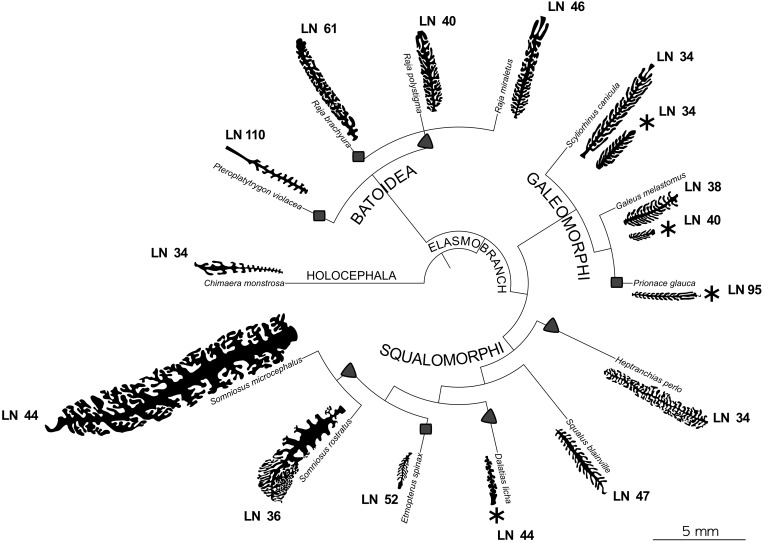
Phylogenetic tree of the species of interest. For each species the silhouette of a illustrative primary lamella with secondary folds is plotted. All the silhouettes are proportionally drawn, having the same scale. For the species where two specimens were analyzed, both the silhouettes are present. For each species the lamellar number (LN) is reported. Specimens with an asterisk are those which are possibly newborn or very young. Chimaera monstrosa is the outgroup and is characterized by less than 50 primary lamellae and by short, unbranched secondary folds. Squares and triangles highlight, respectively, the appearance of a number of primary lamellae higher than 49 and the appearance of branched secondary folds, considering these tracts as derived.